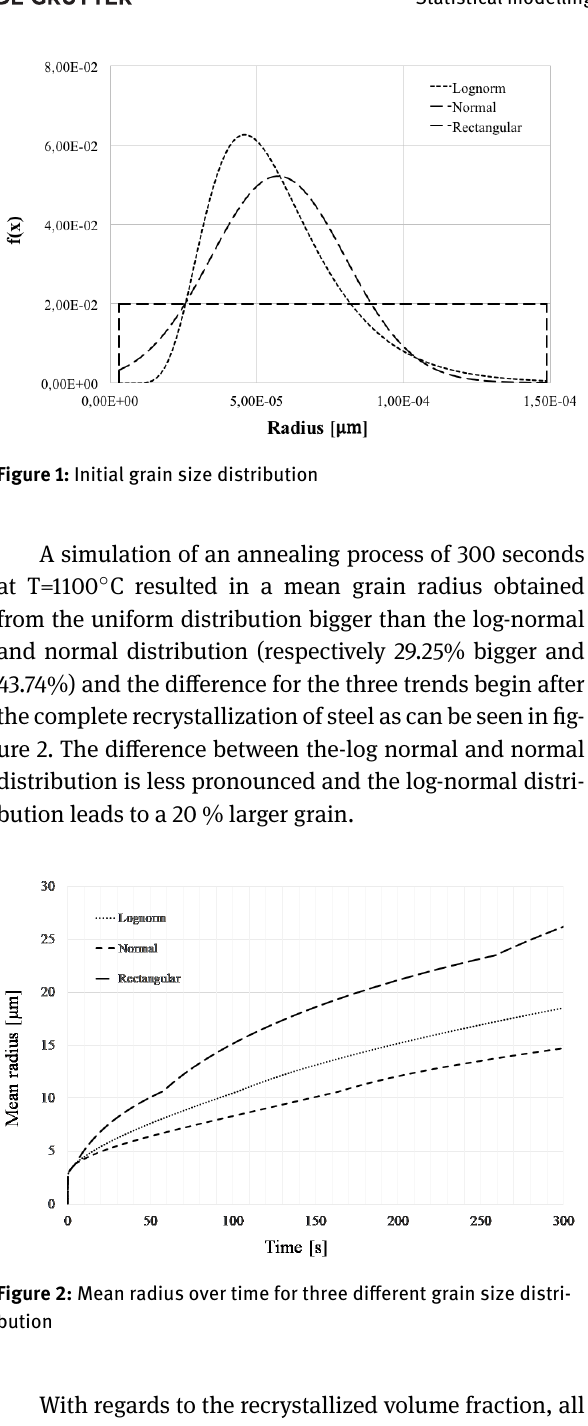
With regards to the recrystallized volume fraction, all